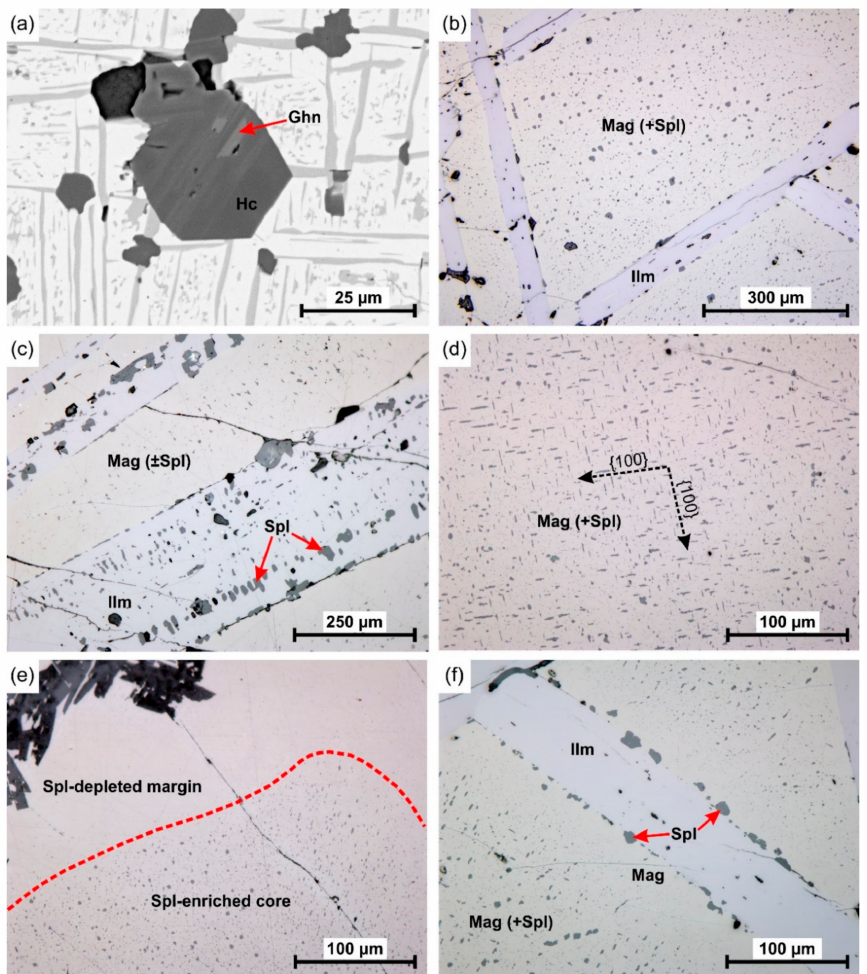
Figure 6. Microphotographs showing exsolutions of hercynite-gahnite in titanomagnetite: ( a ) euhedral granules of hercynite containing lamellae of gahnite; ( b ) granular Al-spinels that are included in a magnetite matrix; ( c ) rectilinear alignments of granular Al-spinels (Al-spinel strings) within a thick lamella of Ilmenite-E1; ( d ) thin Al-spinel discs parallel to the {100} lattice planes of the magnetite structure; ( e ) zonation of the Al-spinel distribution within a titanomagnetite grain; ( f ) a thick lamella of Ilmenite-E1 in titanomagnetite containing abundant Al-spinel exsolutions; note the absence of Al-spinel in the immediate vicinity of the lamella. The microphotograph ( a ) was taken by SEM, whereas all the others were taken by optical microscope. Ghn, gahnite; Hc, hercynite; Ilm, ilmenite; Mag, magnetite; Spl,